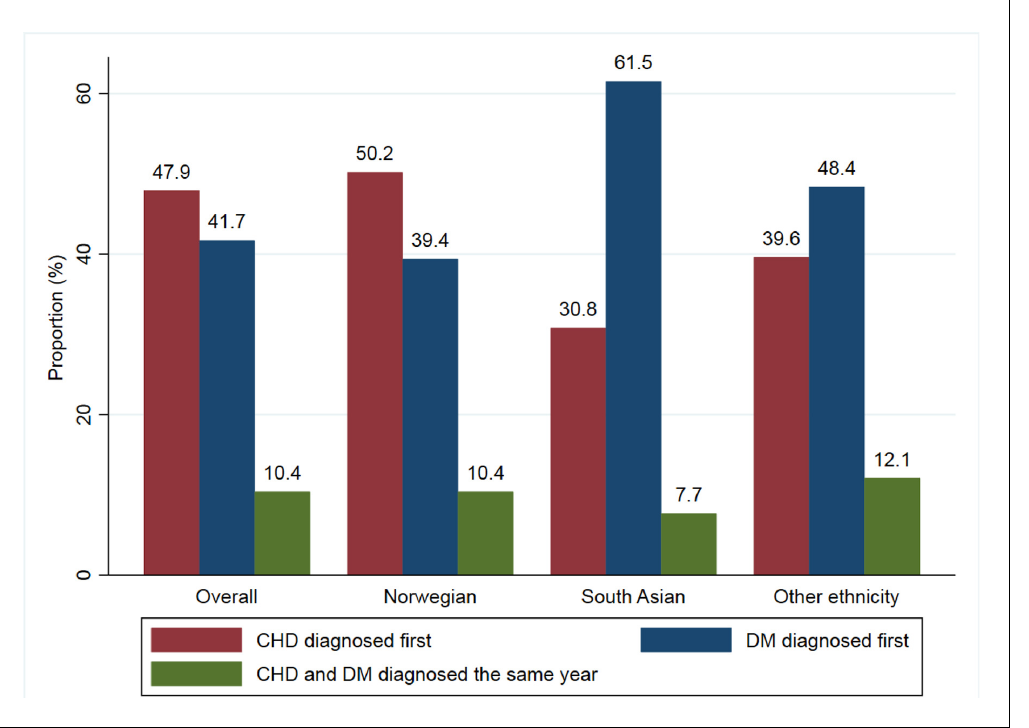
Figure 2. Proportions of patients where CHD was diagnosed (cid:21) 1 year previously, the same year, and (cid:21) 1 year after the diagnosis of type 2 diabetes (overall and in different ethnic groups) CHD = coronary heart disease. DM = diabetes